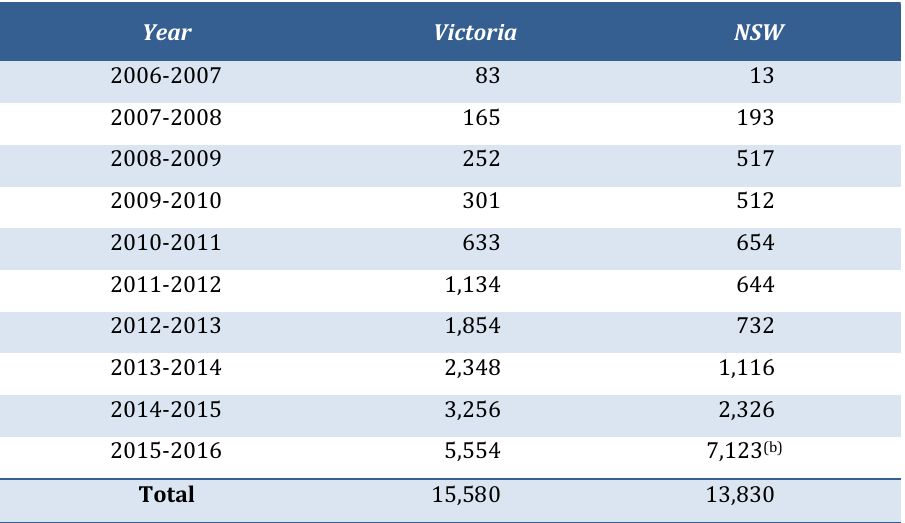
Table 3: Drug driving ‘presence’ offences in Victoria and NSW: Charges 2006 ‐ 2016 (a) Year Victoria